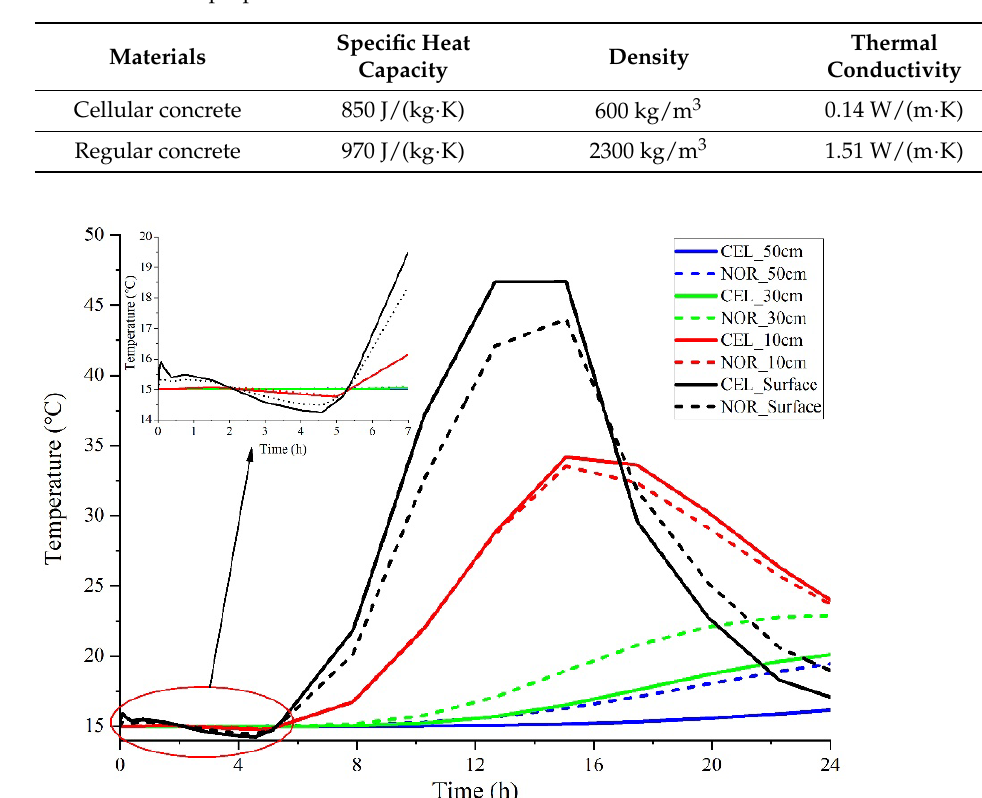
Figure 13. Impact of material properties on temperature distribution. CEL: cellular concrete; NOR: normal concrete).